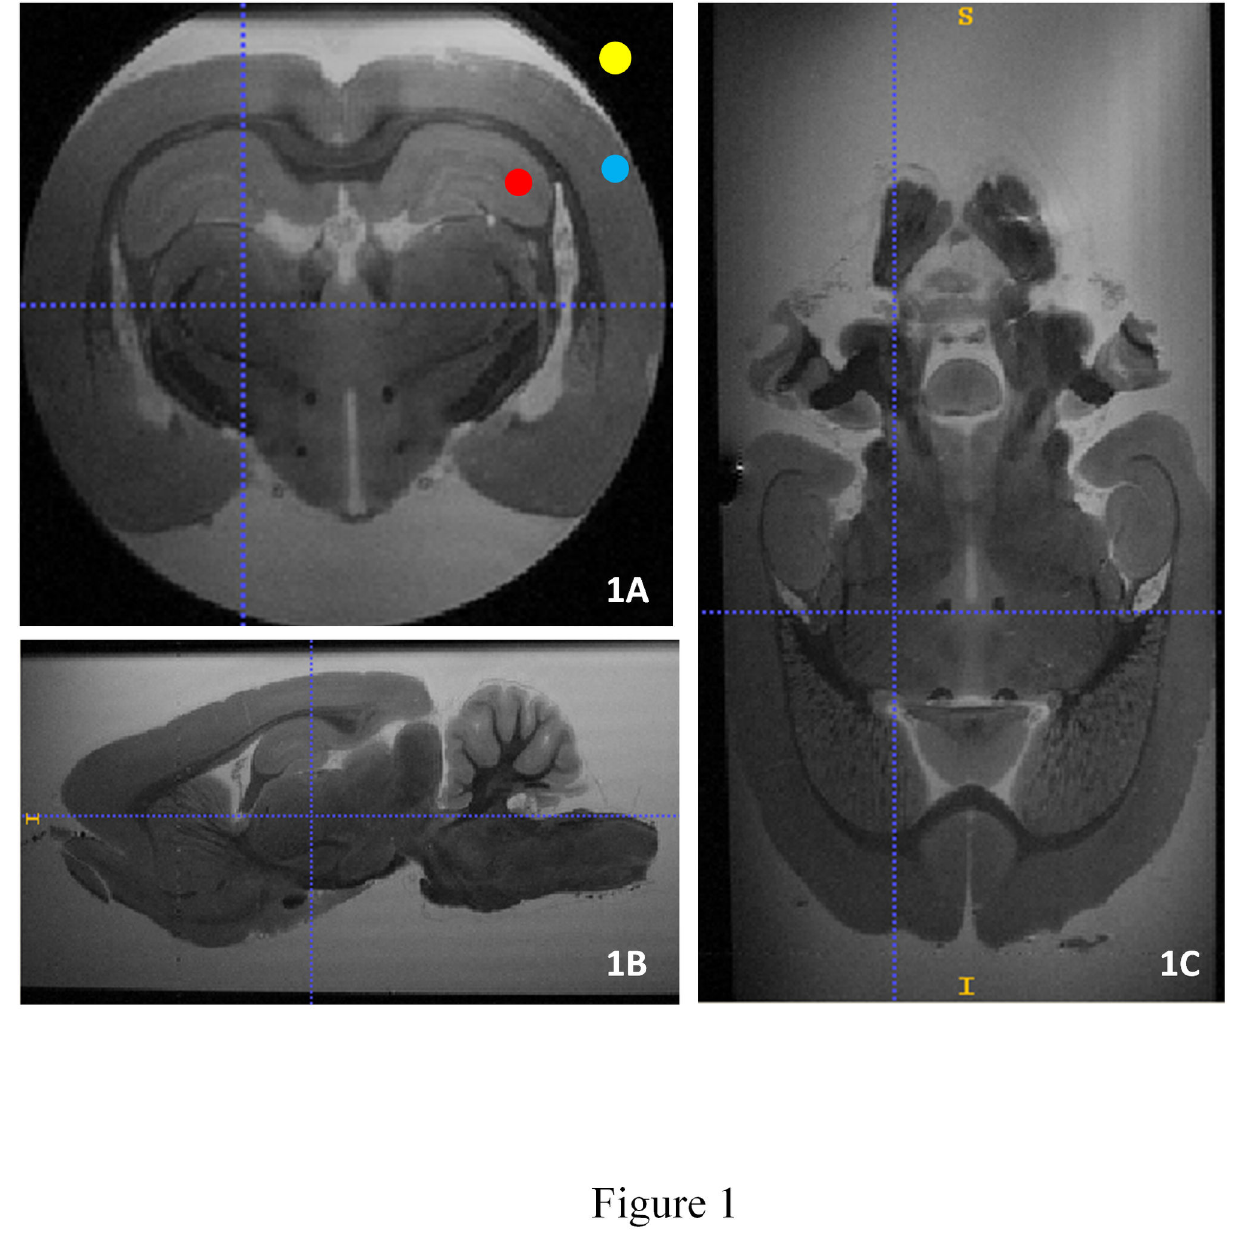
Figure 1. Regions of interest and 3D MRI acquisition. Positioning of ROI for the calculation of SNR and three-plane view of rat hippocampus. Blue: ROI placed on the cortex, red: ROI placed on the hippocampus, yellow: ROI placed on the background of the image for the noise calculation. a: coronal view, 1B: sagital view, 1C: axial view.